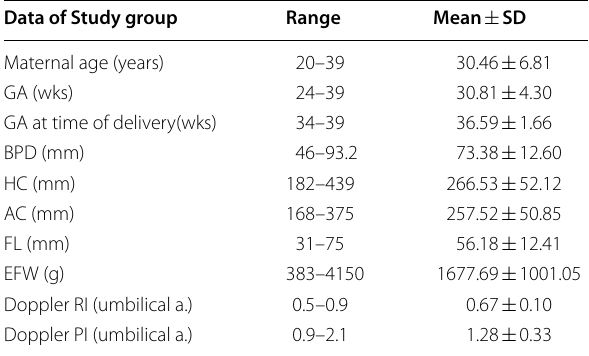
Table 2 Distribution of demographic data of included study